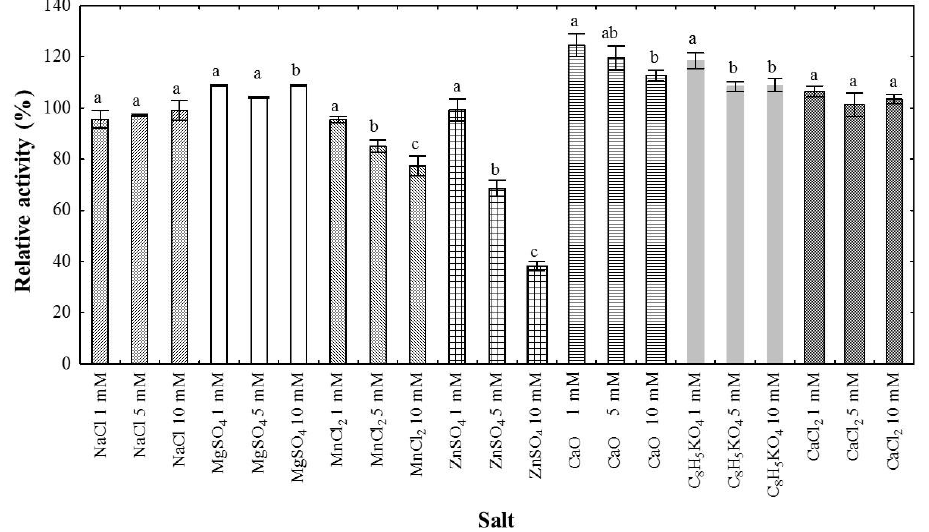
Figure 4. Effect of salt molarity on the activity of the purified protease from Bacillus sp. P45. Bars are the means ± standard deviations of three independent experiments. The statistical analysis was per- formed through ANOVA, followed by Tukey’s test. Equal lowercase letters represent no significant differences at the 5% level.